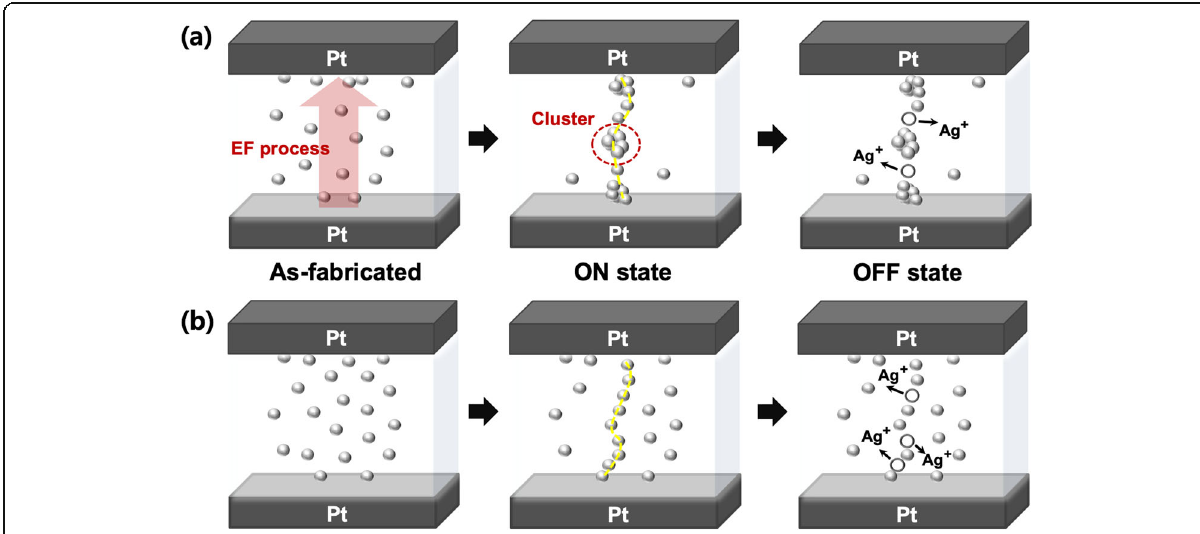
Fig. 5 Suggested mechanism of TS in an Ag-doped HfOx device. The first Ag filament formation/rupture for TS behavior in a EF-needed (D2) and b EF-free (D3)